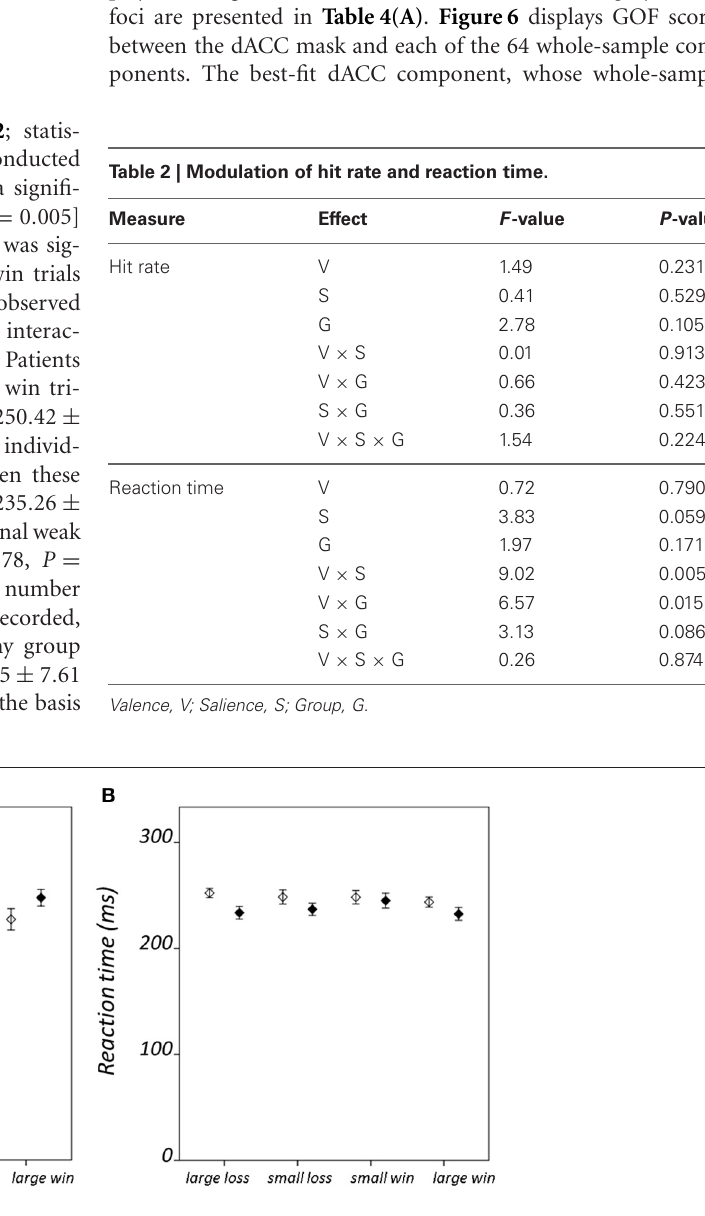
FIGURE 2 | Condition-specific behavioral results. Showing (A) hit rate, and (B) reaction time. Error bars denote standard error of the mean. Healthy group results are shown in black and schizophrenia group results in white.